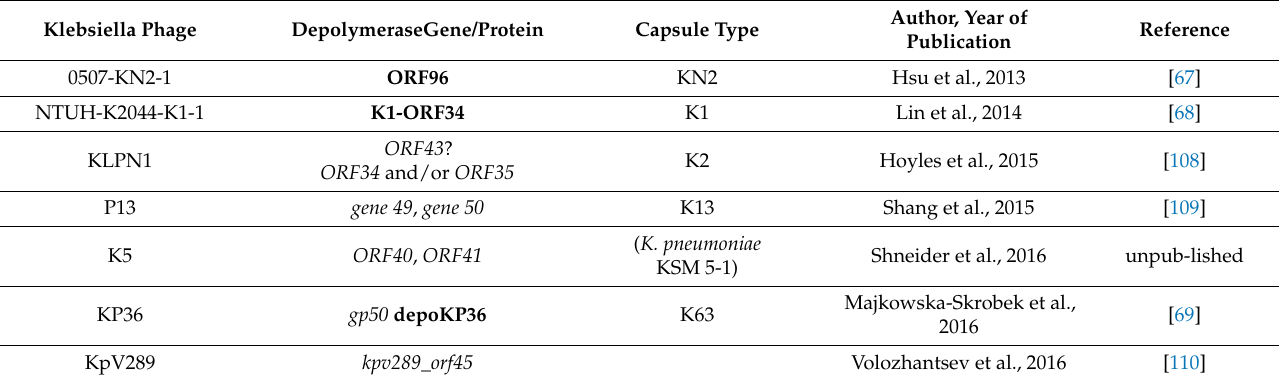
Table 3. List of hitherto published Klebsiella phage depolymerases. List is focusing on studies